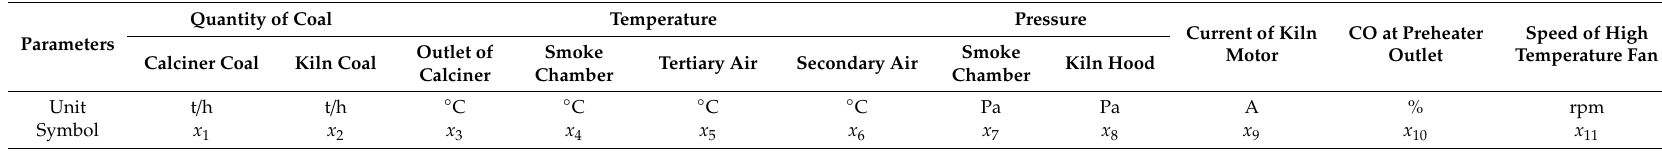
Table 1. Summary of key burning